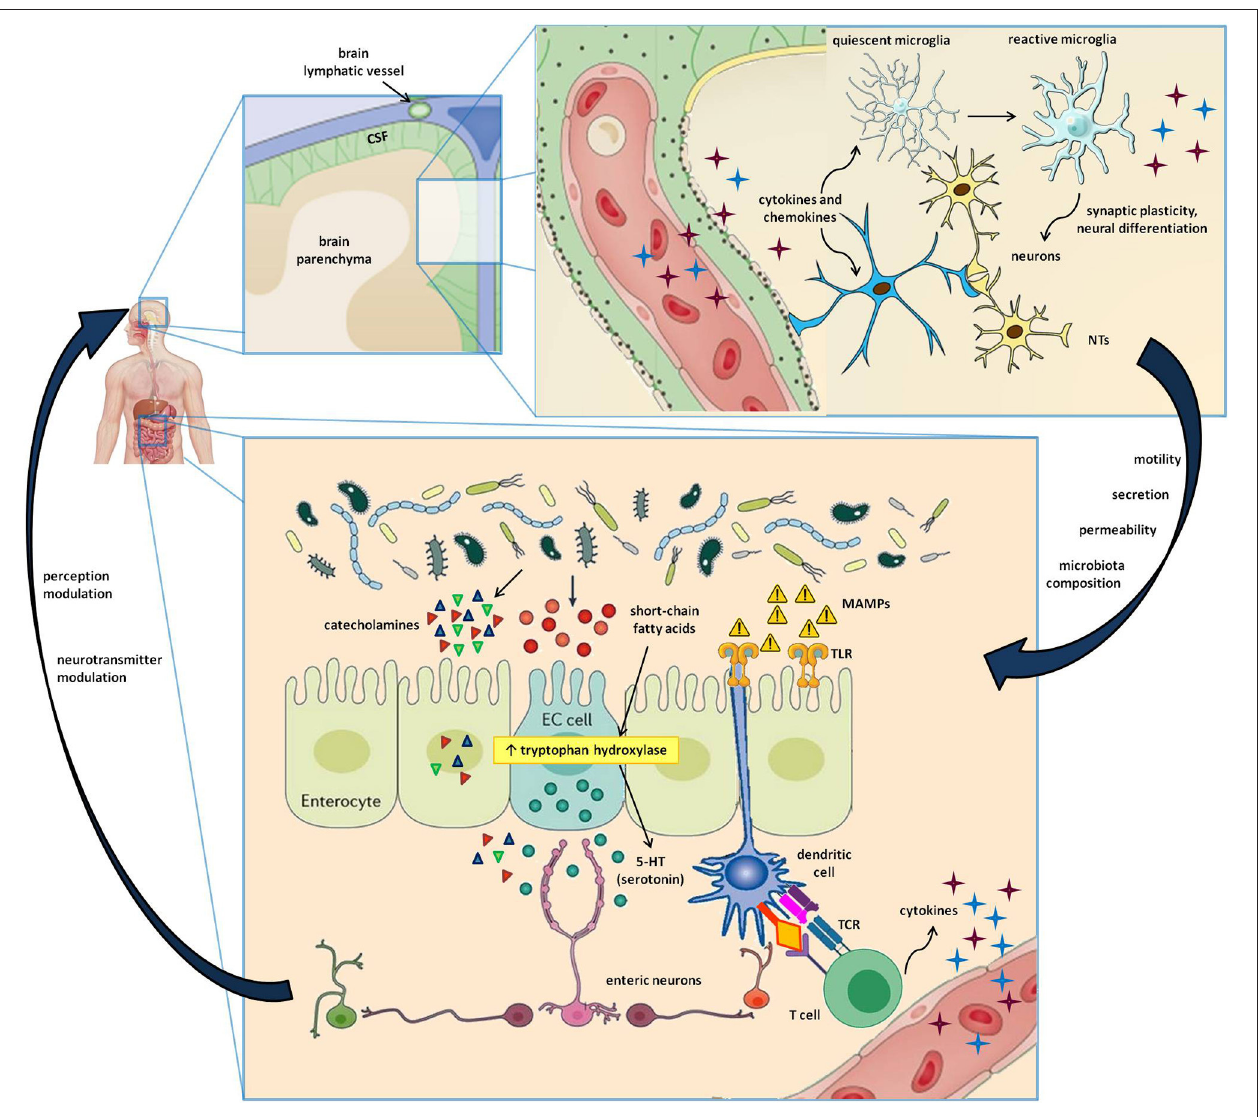
FIGURE 1 | Cells and molecules involved in the gut-brain-immune axis. The lower box represents the intestinal microenvironment, where microbial niches interact with the gut mucosa by directly secreting active metabolites or by indirectly stimulating the release of neurotransmitters by enteroendocrine cells (EC cells). Furthermore, the microbe-associated molecular patters (MAMPs) stimulate Toll-like receptors (TLR) on enterocytes and dendritic cells, resulting in innate and adaptive immune triggers. The upper box shows a magnification of the cerebral parenchima—blood-brain barrier interface, where neurons, astrocytes, microglial cells, and immune cells carried by brain lymphatics all take part in a well-coordinated interplay. In addition to the signals provided by circulating molecules acting in a paracrine and endocrine fashion, the bidirectional gut-brain interaction includes afferent and efferent neural pathways also involving the autonomous and the enteric nervous systems, resulting in modulation of perception, gut motility, secretion, mucosal permeability, and even changes in the microbial